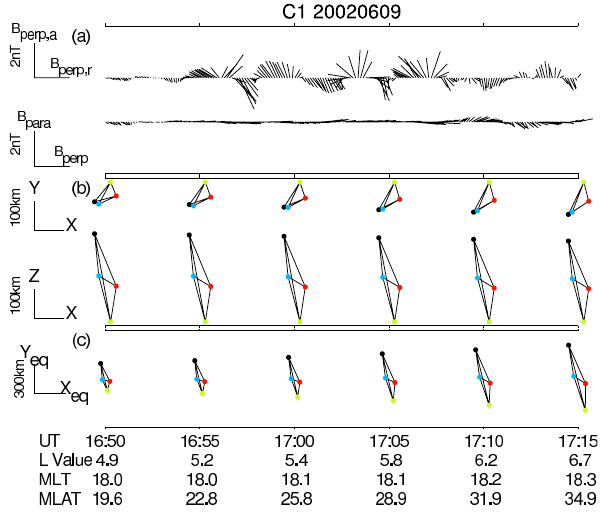
Fig. 12. Cluster data during a plume crossing from 16:50 to 17:15UT on 9 June 2002. Each panel shows the same quantity as Fig. 8.